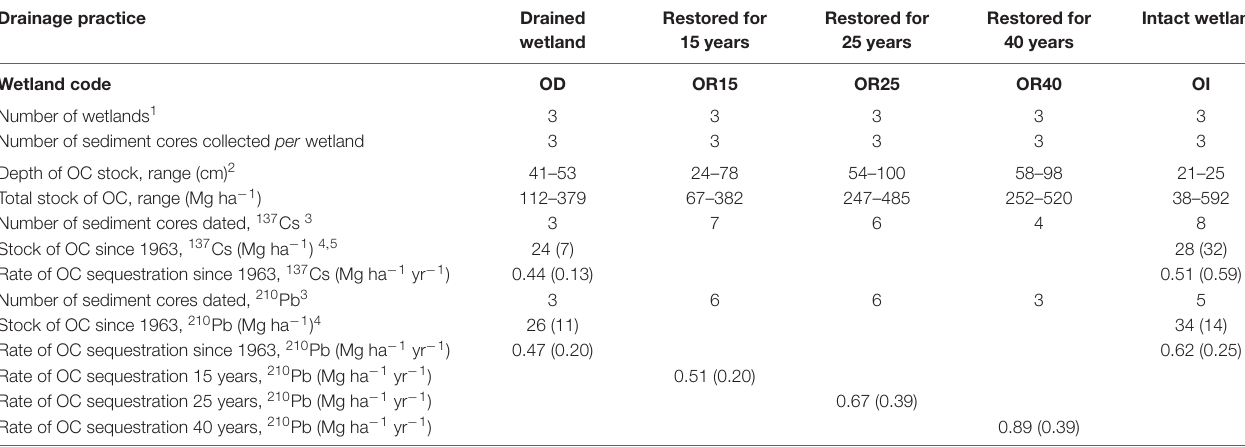
TABLE 1 | Wetland organic carbon (OC) stocks and sequestration rates estimated from sediment cores and using fallout radionuclides for